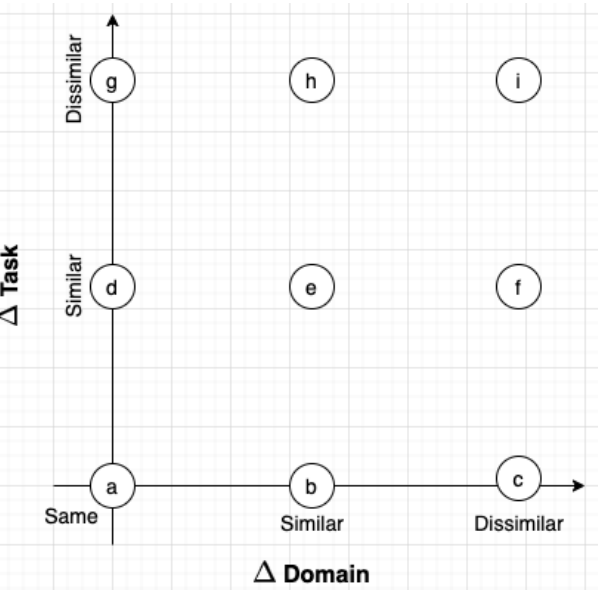
Figure 2. The two-dimensional spectrum of “similarity” between source and target domains and tasks, with the origin ( a ) representing the same task and domain. For clarity, the settings that describe ( a – i ) are provided in Table